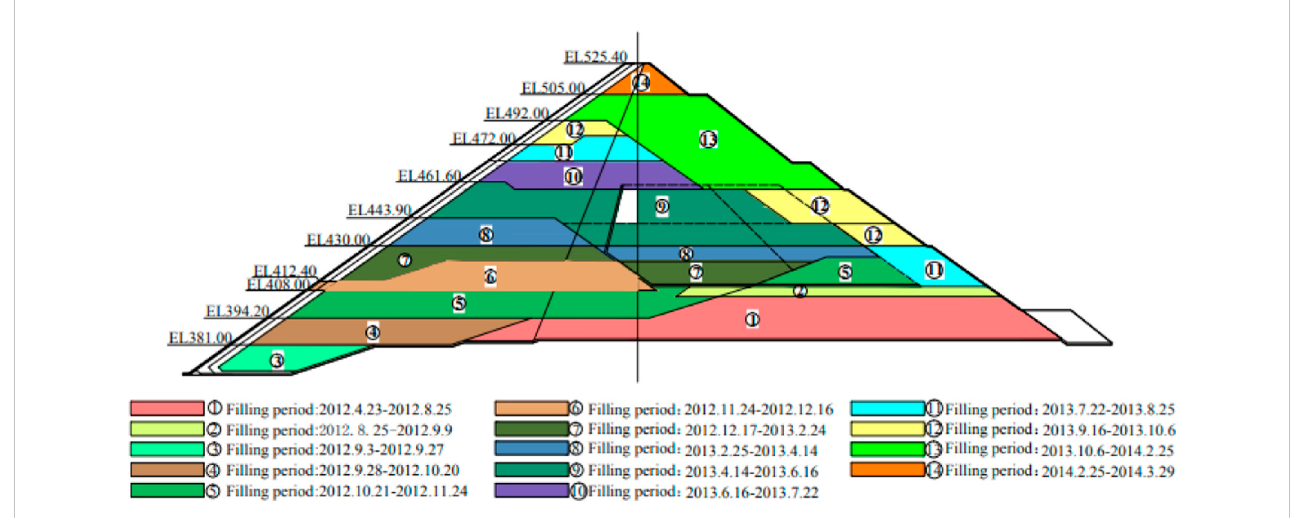
FIGURE 3 Dam fi lling sequence diagram.